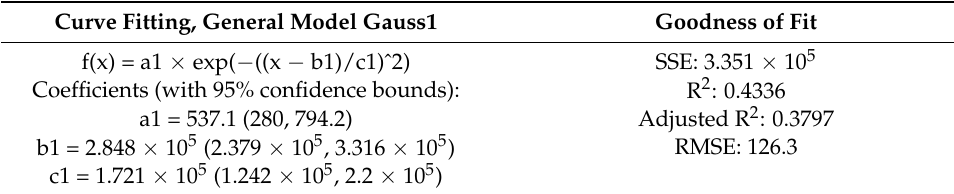
Figure 13. Relationship between Vv , T and λ values. Table 3. Gaussian curve fitting model parameters for Vv , T vs. λ . Table 2. Gaussian curve fitting model parameters for Vv vs. T .